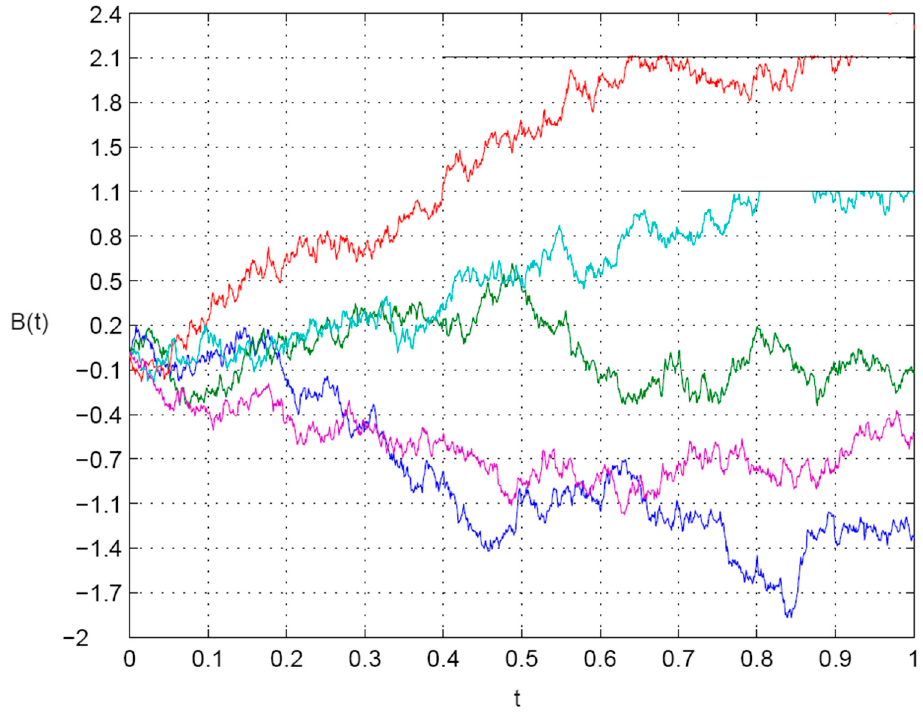
Figure 1. Brownian motion paths.